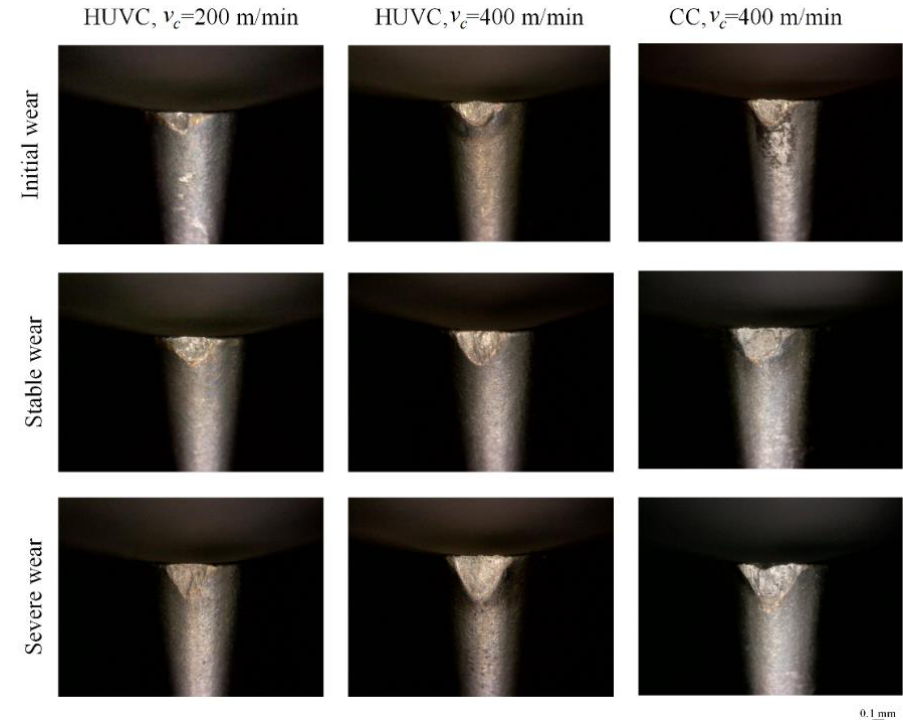
Figure 11. Flank wear at different cutting speeds at different stages of cemented carbide tools when machining Ti alloys. The cooling pressure, duty cycle, feed per revolution, and cutting depth are 20 MPa, 0.5, 0.005 mm/r, and 0.05 mm, respectively. 𝑣 𝑐 , cutting speed.